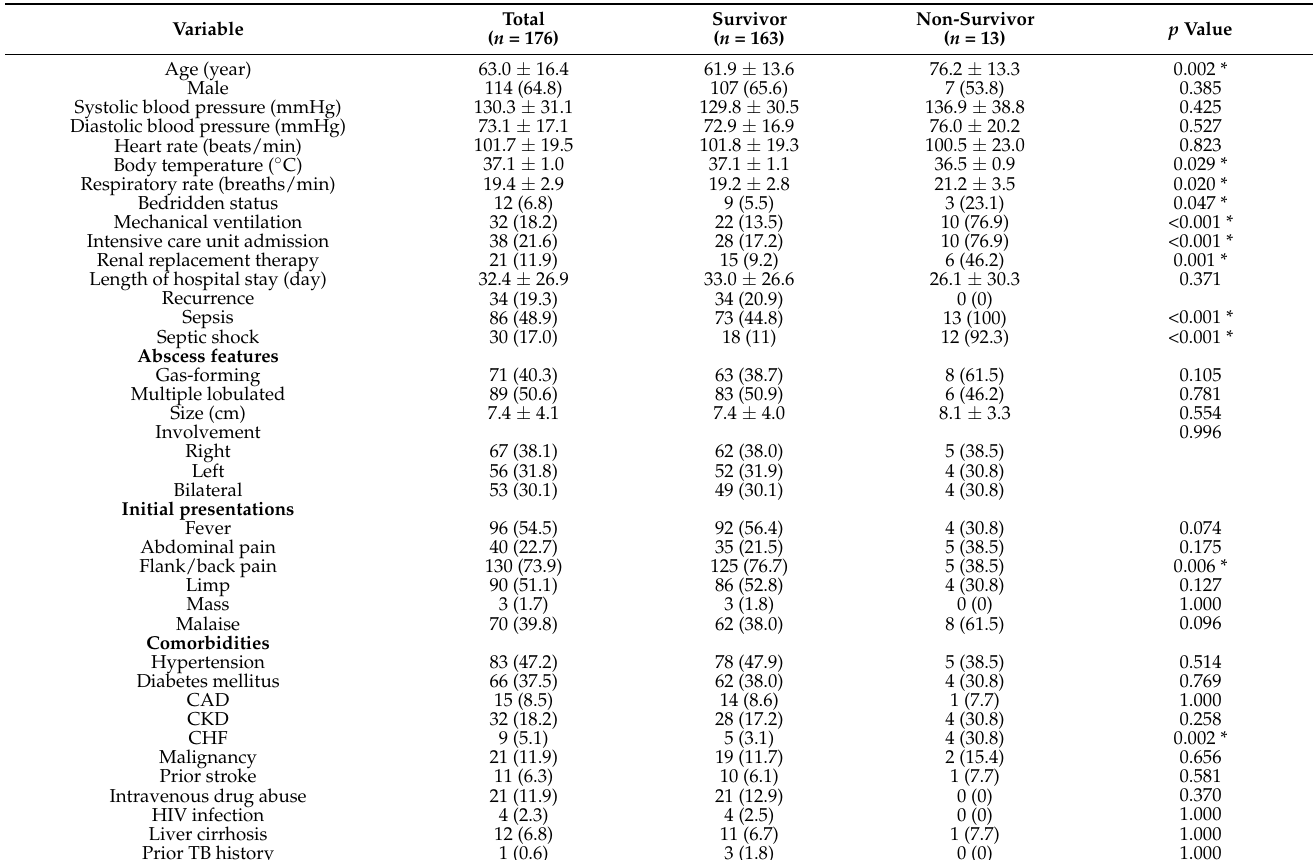
Table 1. Demographics, clinical characteristics, laboratory results, and treatment modalities by survival status in patients with iliopsoas